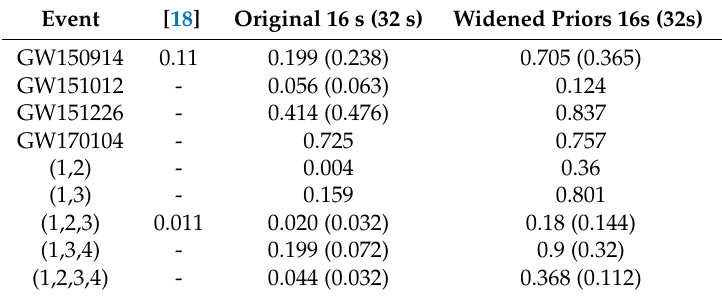
Table 11. Comparison of p -values obtained in [18] and using larger portion of data (4096 s of LOSC data) [23]. This data is divided into segments of 16 or 32 s length. Here different combinations of the events are considered, denoted as (GW150914, GW151012, GW151226, GW170104) Having the original priors, the Poisson errors (as suggested in [28]): for GW150914 our p -values are 0.199 0.028 (0.238 0.043), and for (1,2,3) our p -values are 0.02 ± ± errors for the full combination (1,2,3,4) with original priors, are 0.044 The comparison of p -values using widened priors are also shown in this table.